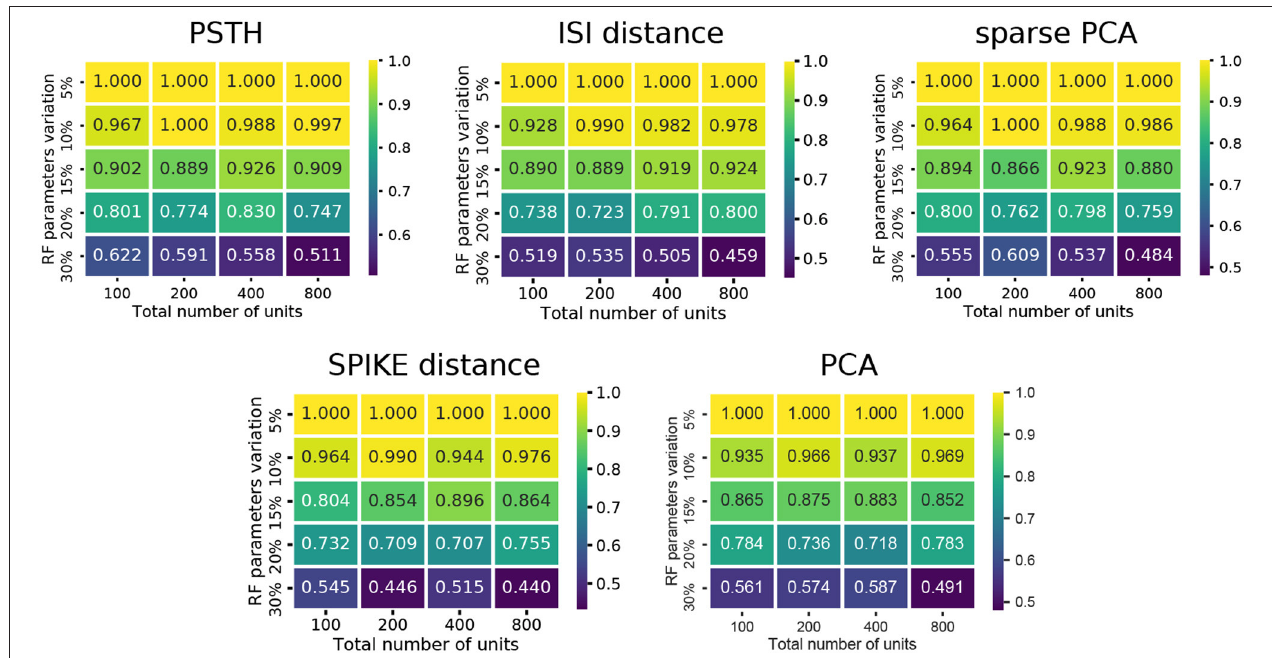
FIGURE 3 | Cluster quality measures as a function of RF variation and total number of units. For each of the five feature sets, the median of four clustering quality scores (adjusted Rand index, adjusted mutual information score, V-measure, and the Fowlkes-Mallows score) are shown for each dataset (140 in total).